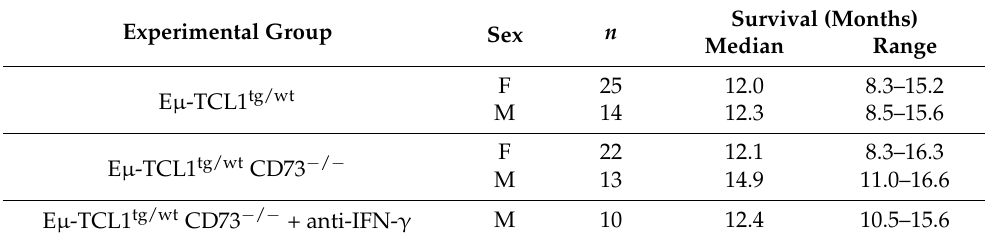
Table 1. Median survival time of experimental groups of E µ -TCL1 tg/wt transgenic mice. Experimental Group